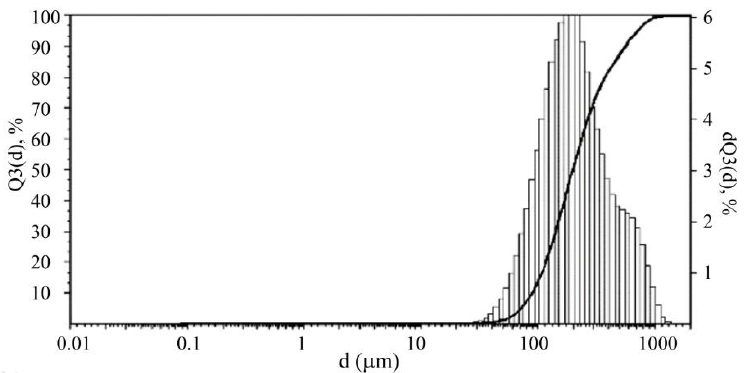
Figure 2. Scanning electron microscopy of thermally reduced graphene oxide.